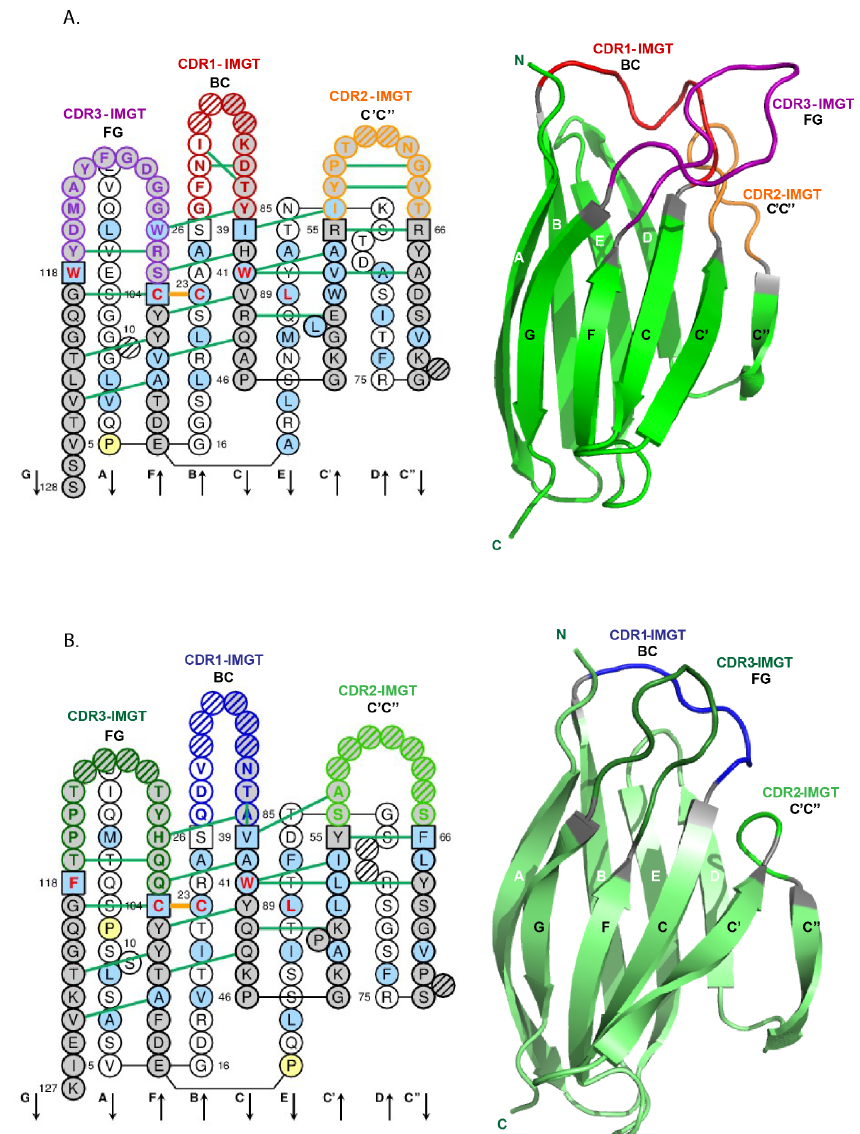
Figure 21. IMGT Collier de Perles of V-DOMAIN on two layers and ribbon representation [94]. ( A ) Trastuzumab VH. ( B ) Trastuzumab V-KAPPA. The IMGT Colliers de Perles on two layers (on the left) show, in the forefront, the GFCC ′ C ′′ strands (forming the sheet located at the interface VH/VL) and, in the back, the ABED strands. The IMGT Colliers de Perles were generated using the IMGT / Collier-de-Perles tool [51] integrated in IMGT / 3Dstructure-DB [57–59]. The CDR1-IMGT, CDR2-IMGT and CDR3-IMGT (corresponding to the BC, C’C” and FG loops, respectively) are represented in red, orange and purple, for the VH and in blue, green and bluegreen, for the VL, here V-KAPPA. The CDR-IMGT lengths are [8.8.13] for VH and [6.3.9] for V-KAPPA. Hatched circles correspond to missing positions according to the IMGT unique numbering for V domain [40,41]. Arrows indicate the direction of the beta strands and their designations in 3D structures. Anchors are shown in squares. Hydrogen bonds (green lines online were automatically added from the experimental structural data). The disulfide bridge (orange line between C23 and C104) was also automatically added from the experimental structural data. The ribbon representation of the 3D structures (on the right) was obtained using PyMOL (http: // www.pymol.org). The identifiers of the chains to which the domains belong are 1n8z_B and 1n8z_A (IMGT ® http: // www.imgt.org, IMGT / 3Dstructure-DB). (With permission from M-P. Lefranc and G. Lefranc, LIGM, Founders and Authors of IMGT ® , the international ImMunoGeneTics information system ® , http: //